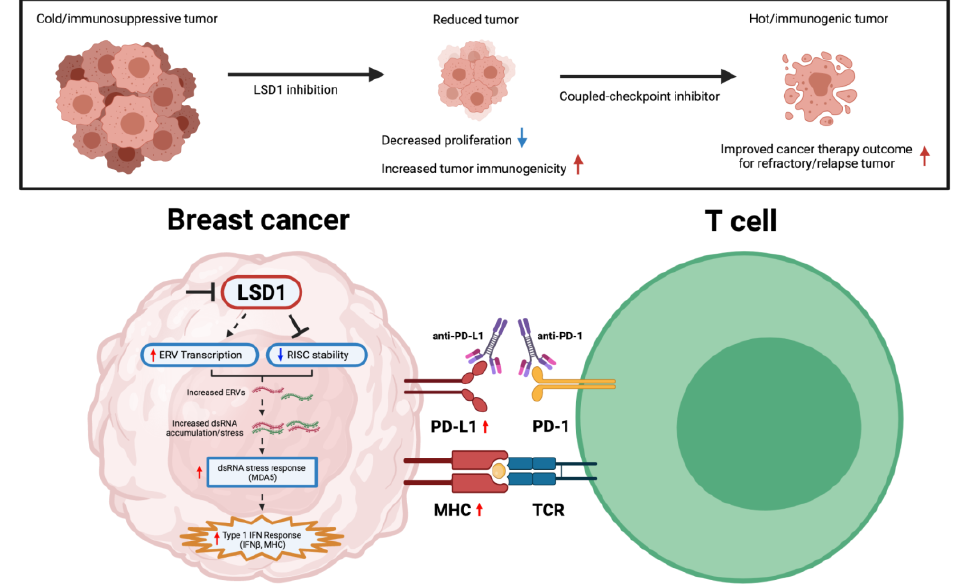
Figure 6. Graphical representation of mechanistic effect upon LSD1 inhibition in eliciting tumor immunogenicity in breast cancers. Red arrows indicate increased level, while blue arrows indicate reduced level. Figure created with BioRender.com (accessed on 2 January 2023).